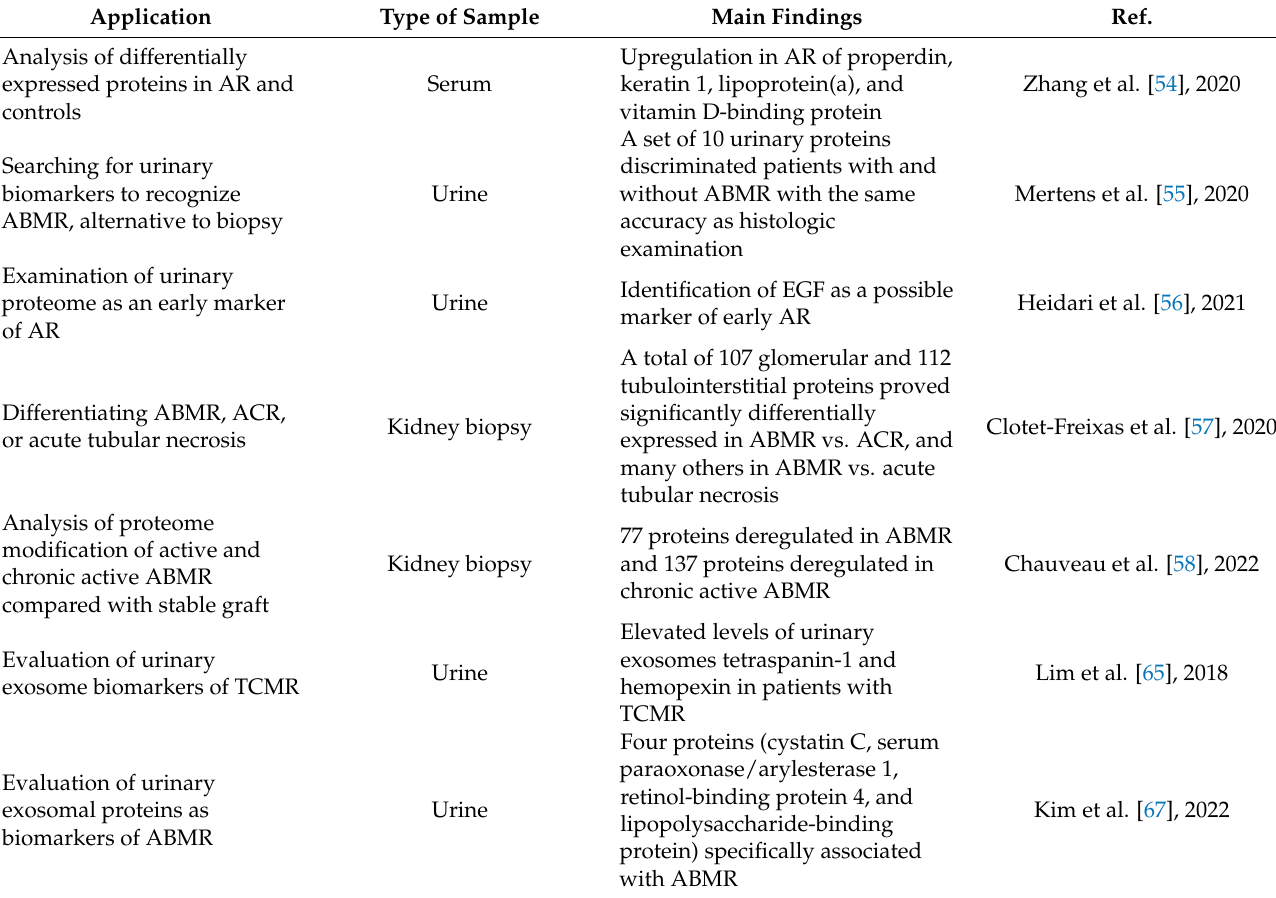
Table 4. Recent proteomic studies on acute rejection in the setting of kidney transplantation. Main Findings